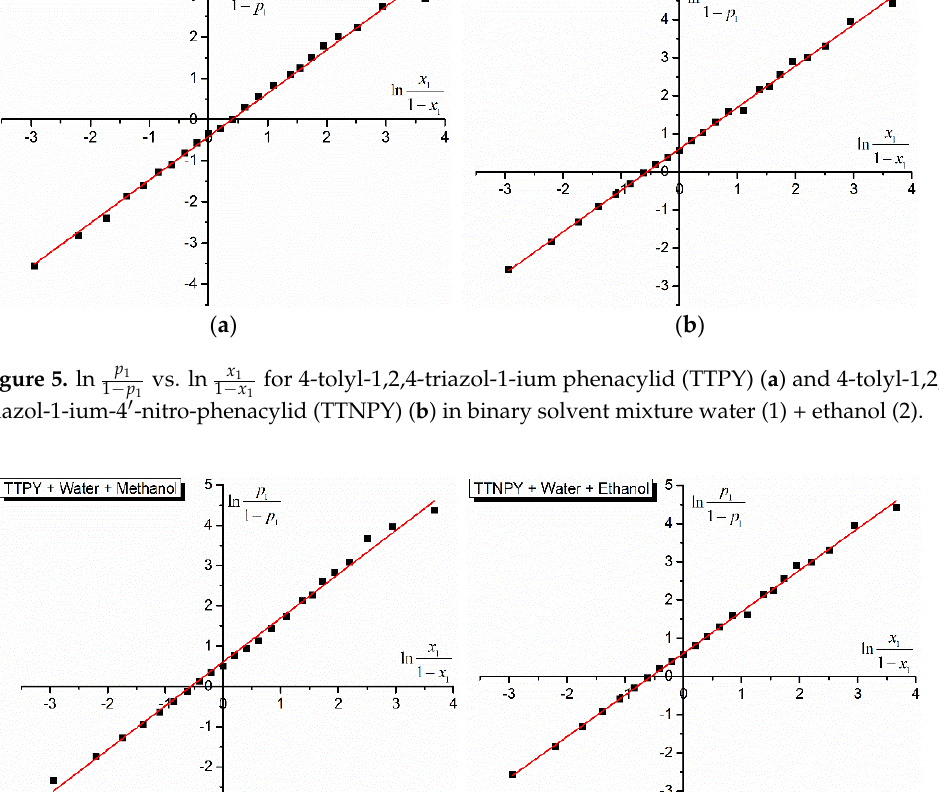
Table 6. Characteristics of the lines